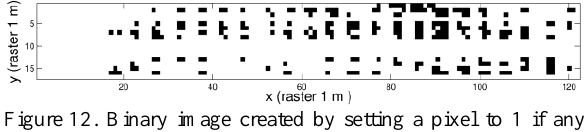
Figure 12. Binary image created by setting a pixel to 1 if any indoor point (shown in Figure 11) is inside the 1 m cell. Figure 13. Façade points from Figure 10 representing the façade shown in Figure 9 with detected window (centre) positions.